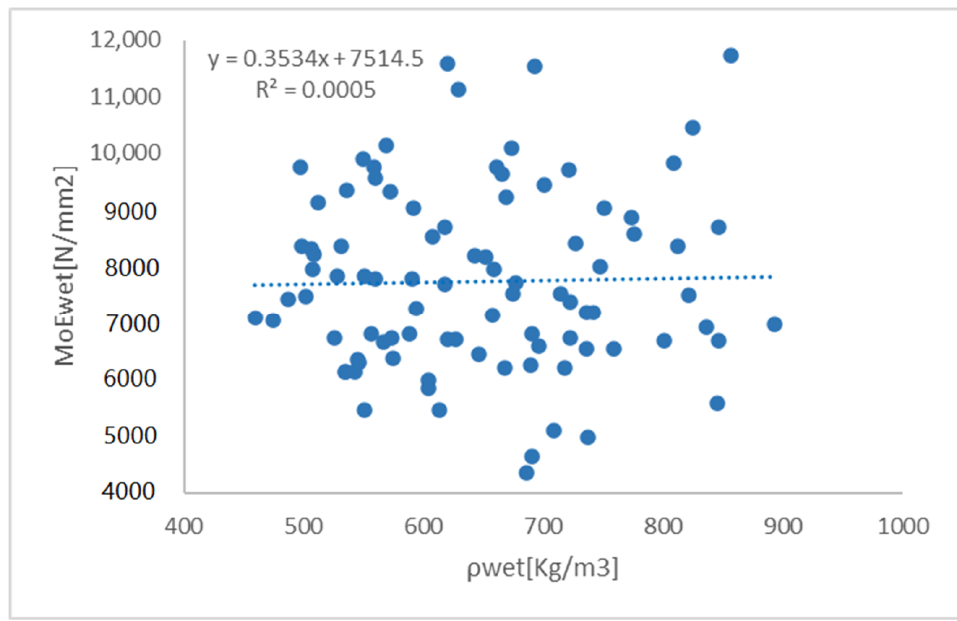
Figure 7. MoE dyn vs. wood density ρ—Wet condition.